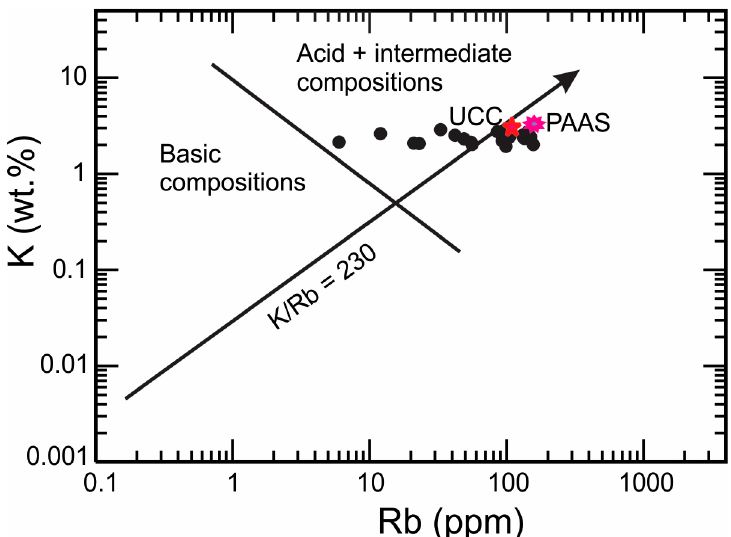
Figure 7. Bivariate log concentration plot of log (K) vs. log (Rb) of the Brahmaputra River sediments relative to a K:Rb ratio of 230, the main trend line of Shaw [43]. Upper continental crust (UCC) and post-Archaean average Australian shale (PAAS) compositions are shown for comparison. Brahmaputra River sediment samples are represented by the black dots.